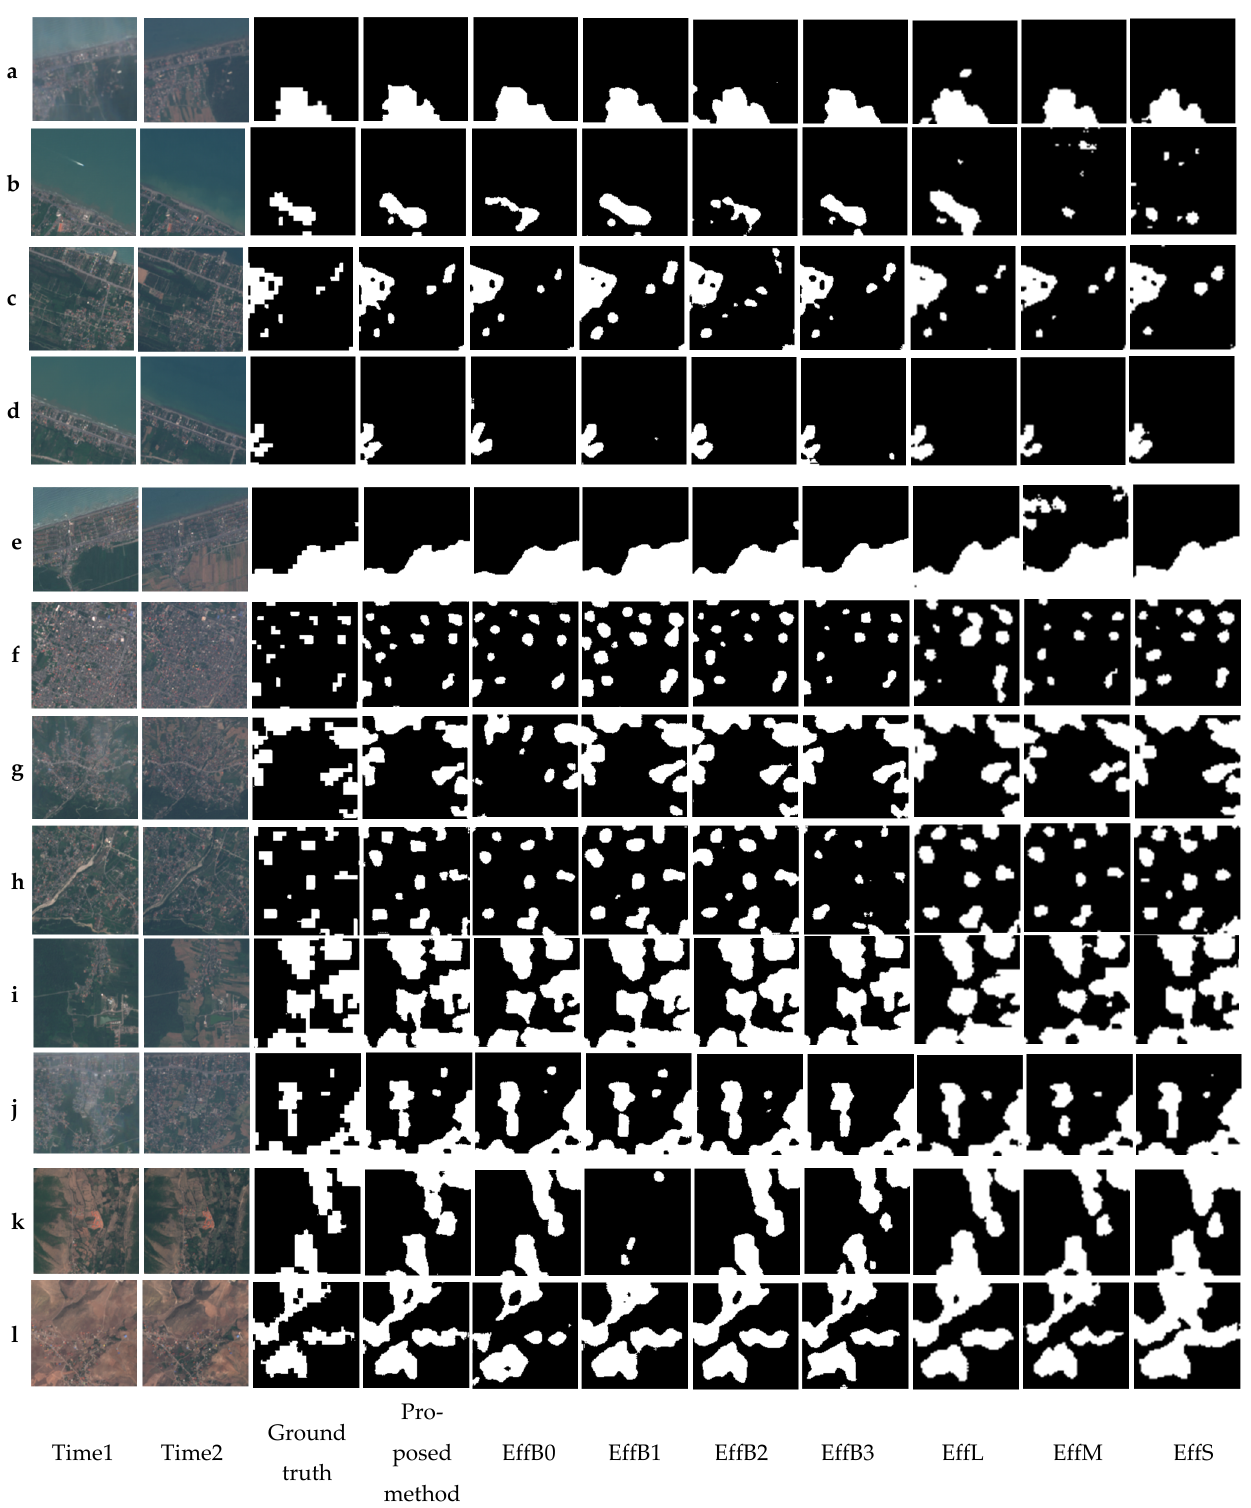
Figure 9. Results of coastal areas ( a – e ), results of areas located near the forest and agricultural land ( f – j ), and results of areas which are located on the foothills ( k , l ).